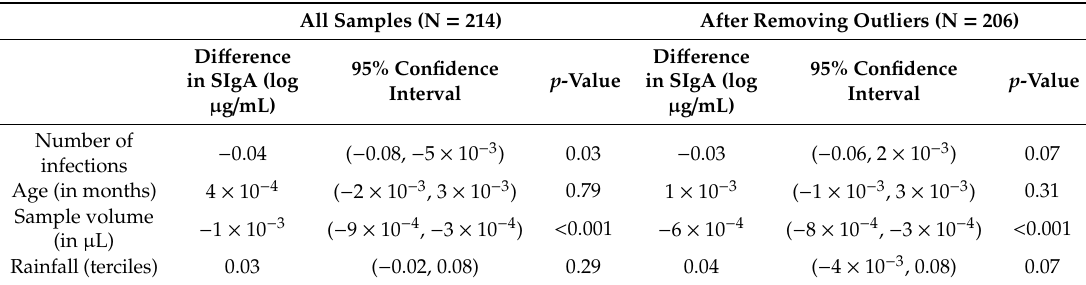
Table 2. Di ff erence in salivary SIgA with a higher number of concurrent infections, after controlling for age (in months), sample volume (in µ L) and 30-day rainfall (in terciles). All Samples (N = 214) After Removing Outliers (N = 206)